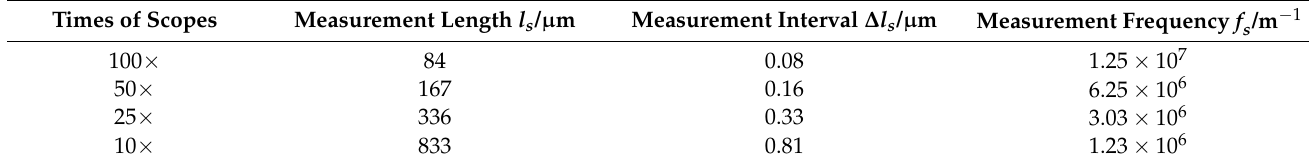
Table 4. Measurement information of experiment sample surface.